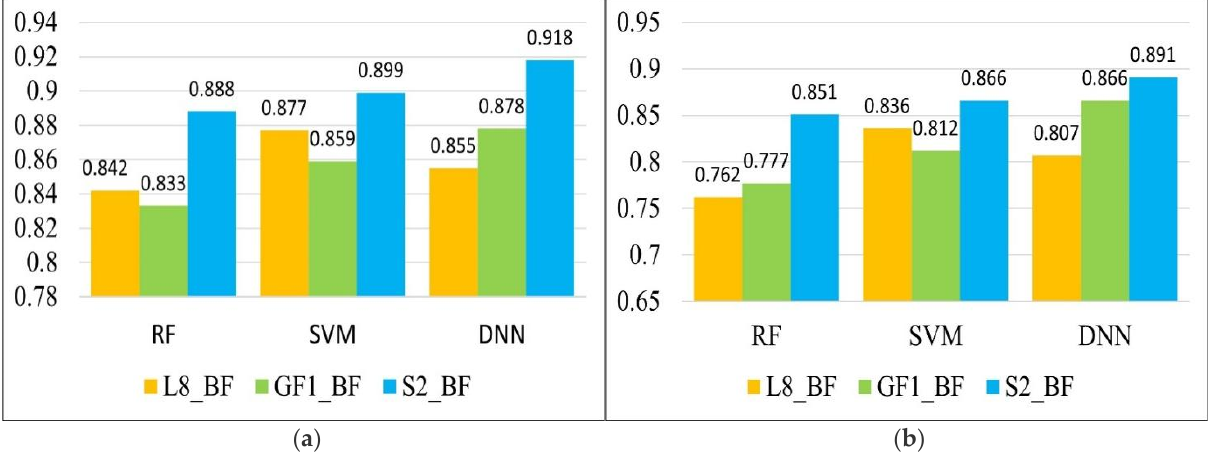
Figure 9. ( a ) Overall accuracy of different BF models; ( b ) kappa coefficient of different BF models.